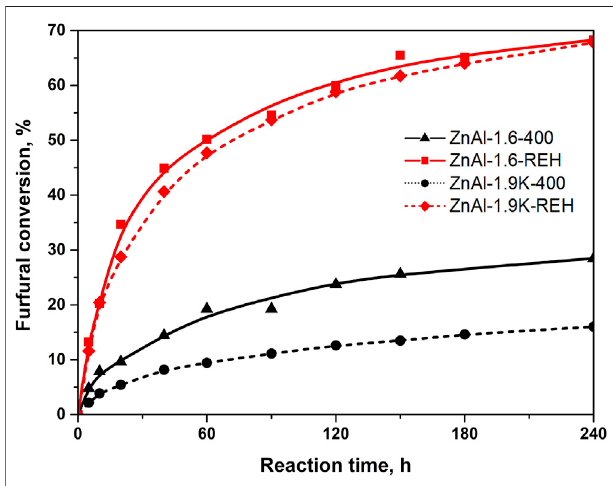
FIGURE 10 | Conversion of furfural in aldol condensation reaction using ZnAl mixed oxides and ZnAl reconstructed LDHs catalysts.